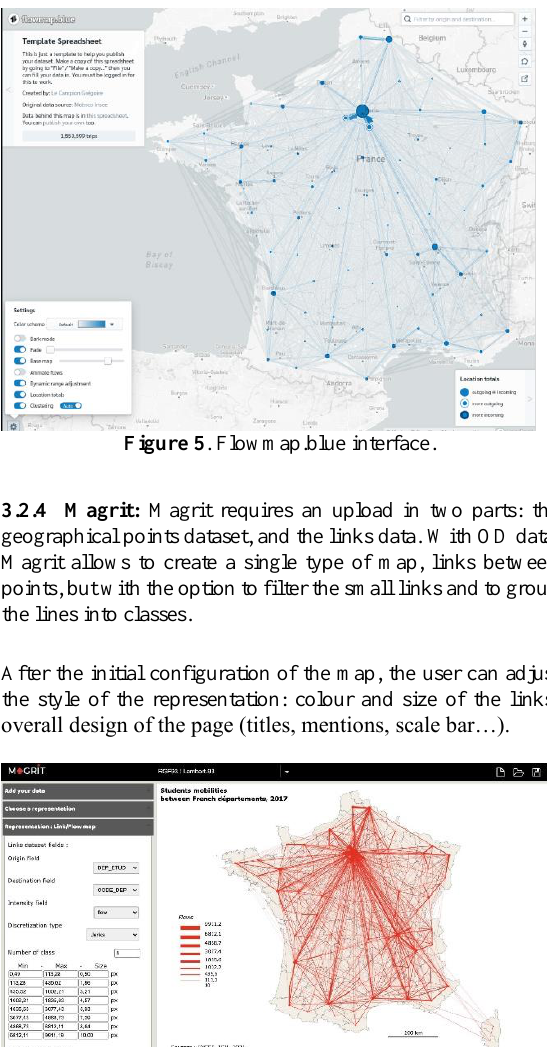
Figure 2 . Styling in Arabesque.